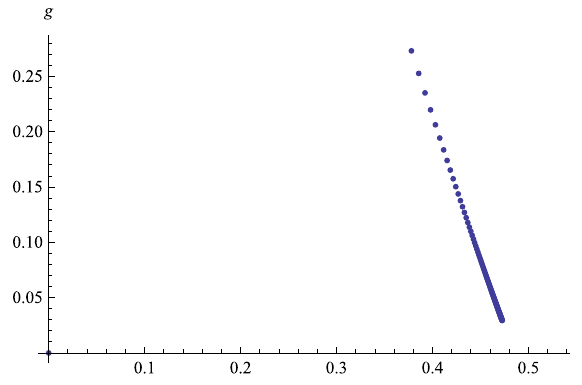
Fig. 1 Flow diagrams for m 2 and g k = 0 . 40266